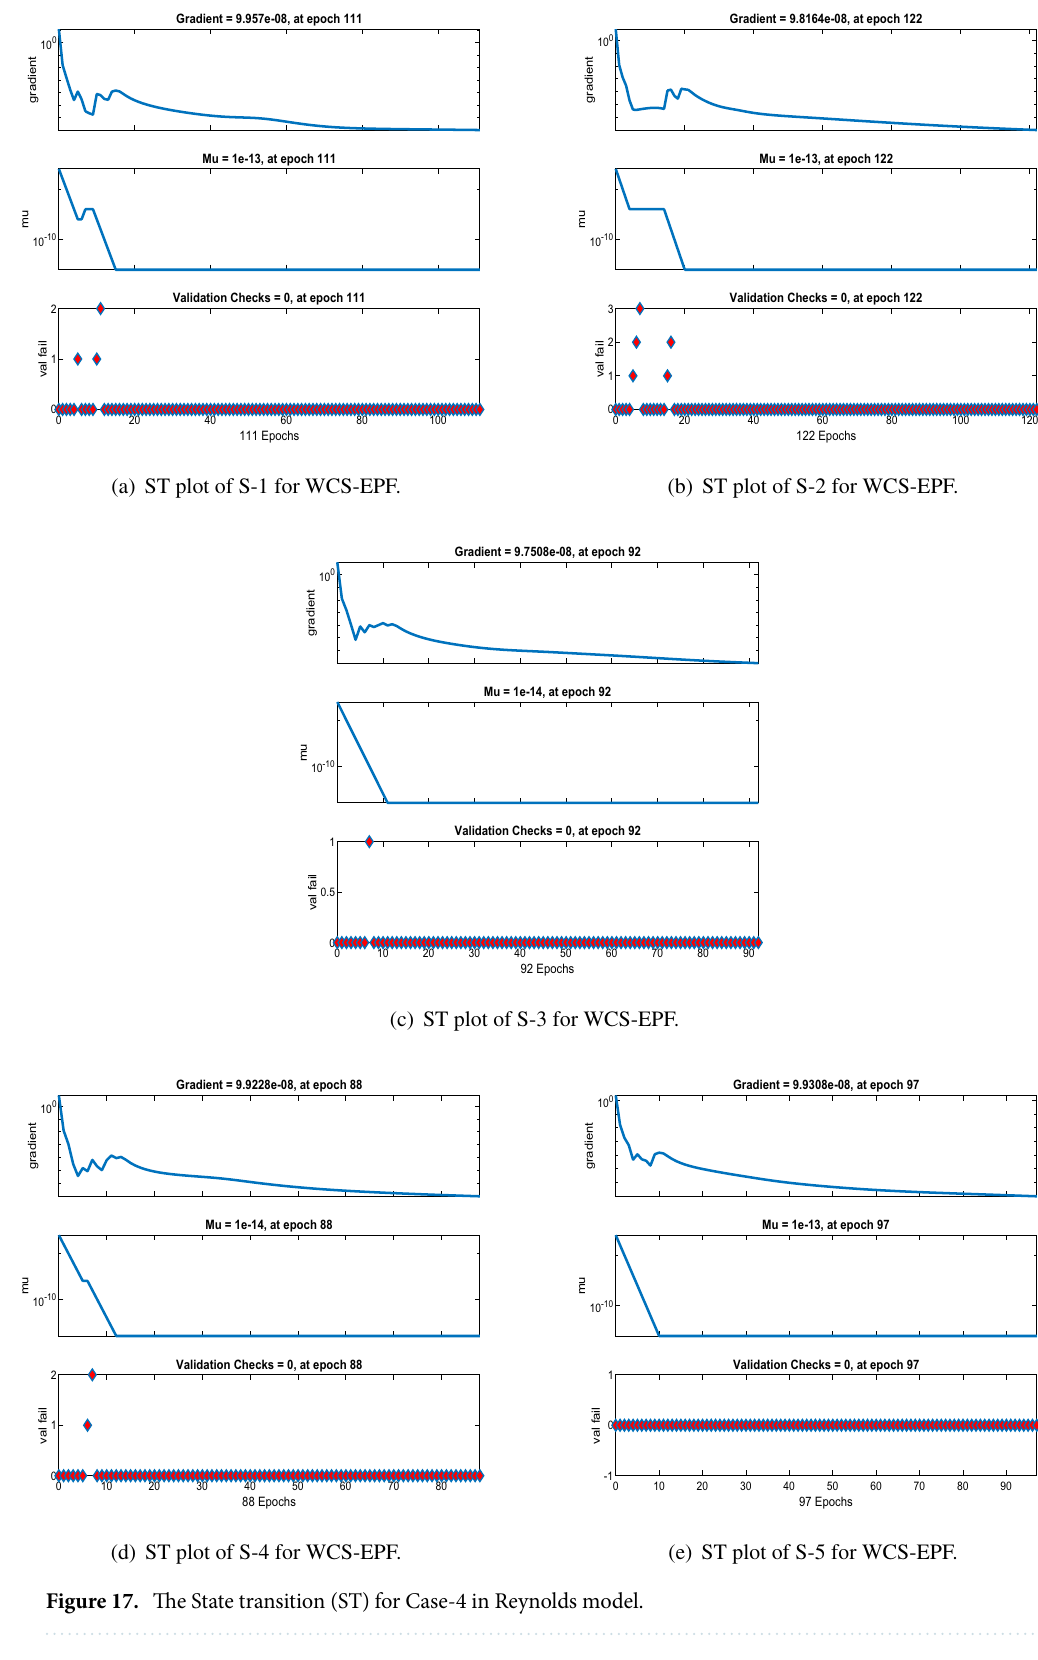
Figure 17. The State transition (ST) for Case-4 in Reynolds